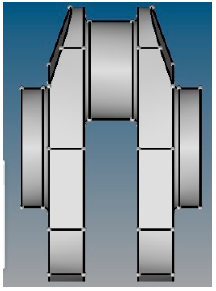
Figure 5. The crankpin of the crankshaft.